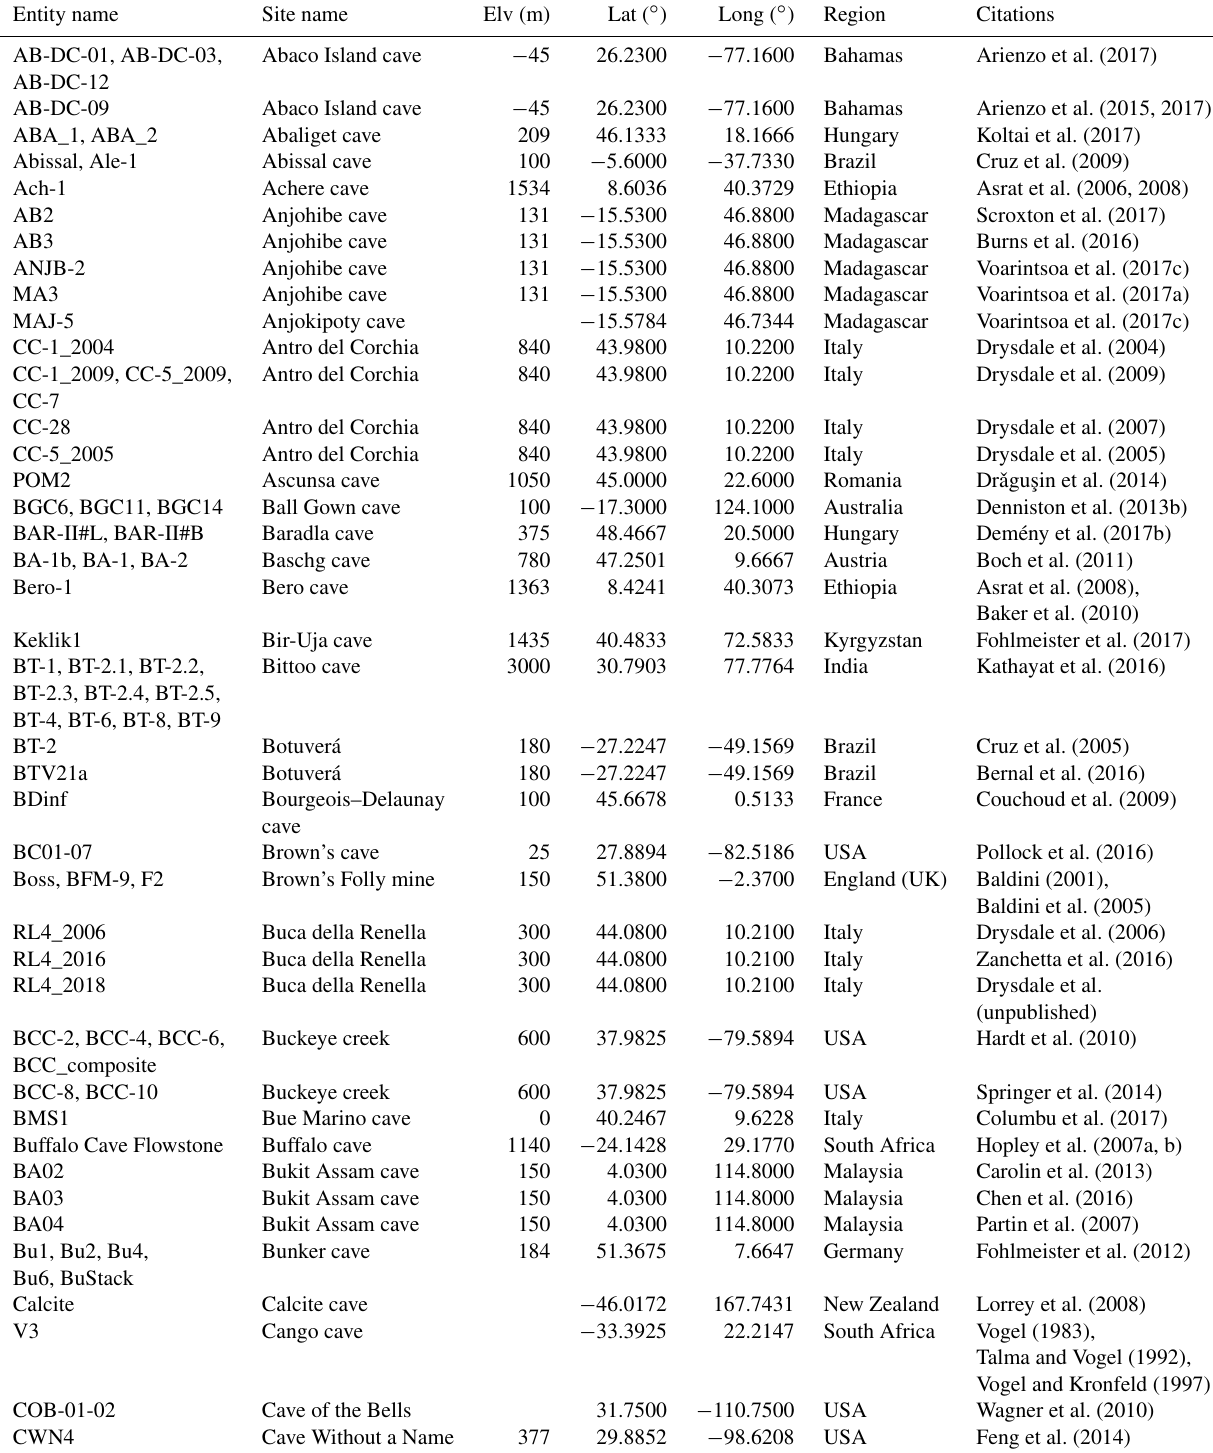
Table 1. Information on speleothem records (entities) in the SISAL_v1 database. Elevation (Elv) is given in metres above sea level and latitude (Lat) and longitude (Long) in decimal degrees. For convenience, we have given the location of each record, although this information is not available in the database itself. Note that the latitude and longitude of Abaliget, Brown’s cave and Uamh an Tartair are given correctly here but are incorrect in the SISAL_v1